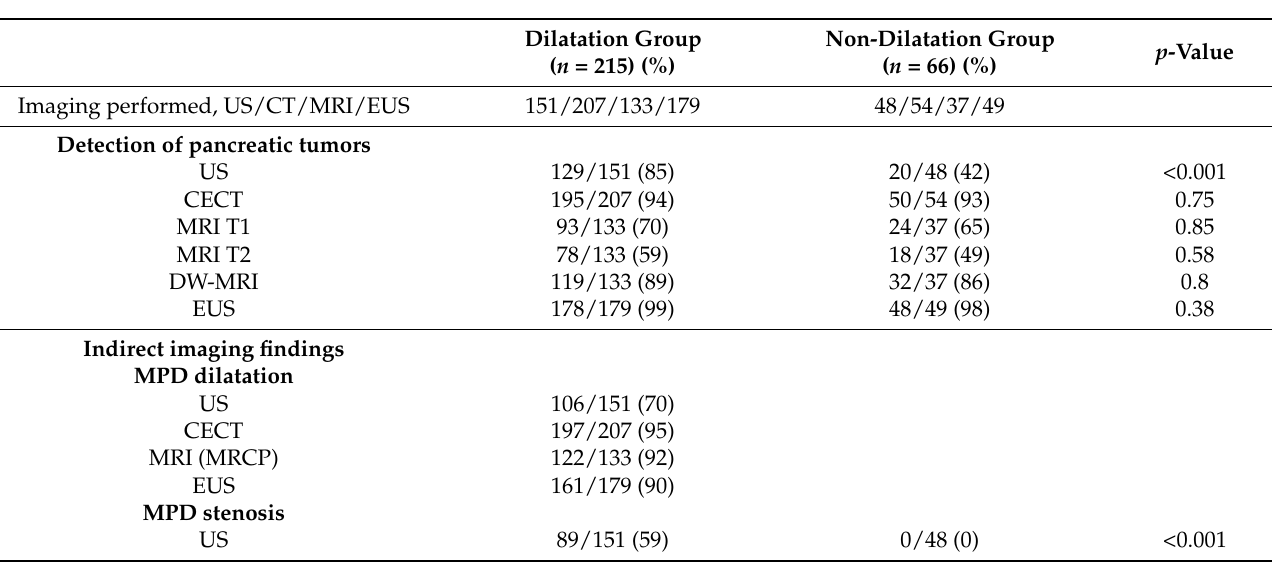
Table 3. Imaging